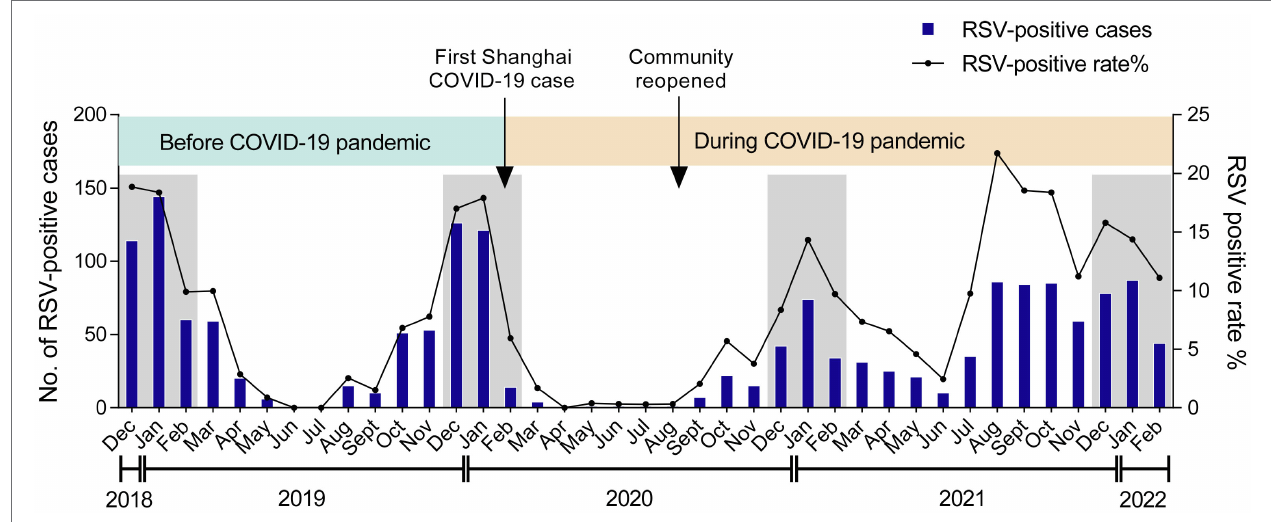
FIGURE 1 | Monthly distribution of RSV among children. The numbers and positive rate of RSV-positive inpatients admitted to the Children’s Hospital of Fudan University from December 2018 to February 2022 were displayed. Arrows labeled the time points when the first COVID-19 case was reported in Shanghai and when the community was reopened. The winter seasons (December–February) are framed by gray